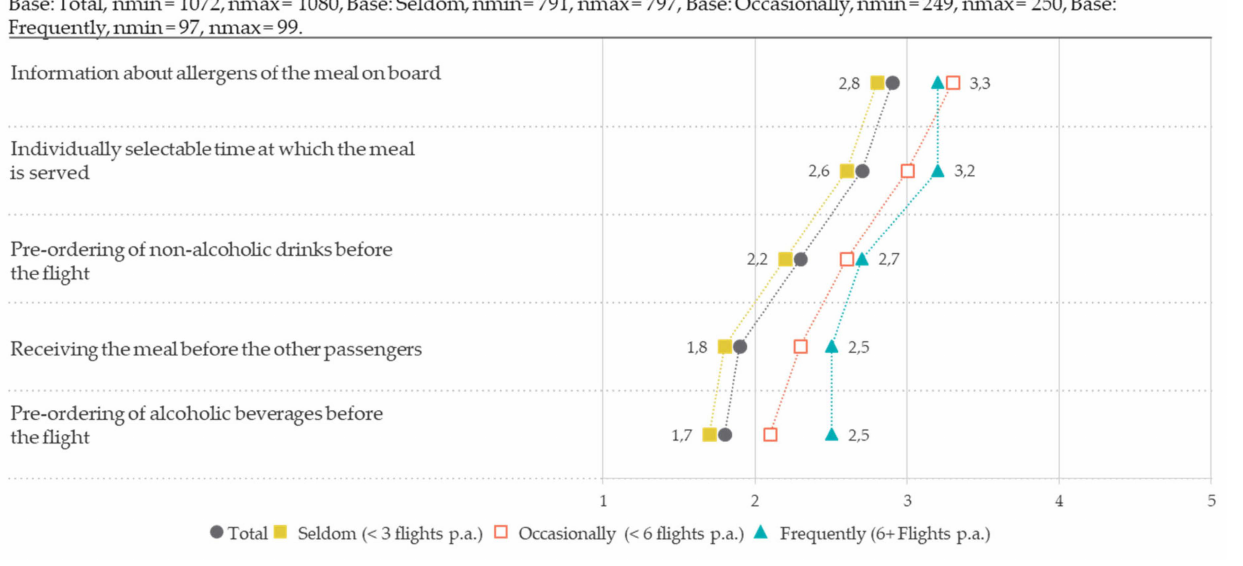
Figure 7. Pre-order choices (in Avg.) by flight frequency. People of different ages have different views on pre-ordering, as shown in Figure 8. In this case, the interest of receiving information about, e.g., allergens, seems to be more important for younger passengers than for older